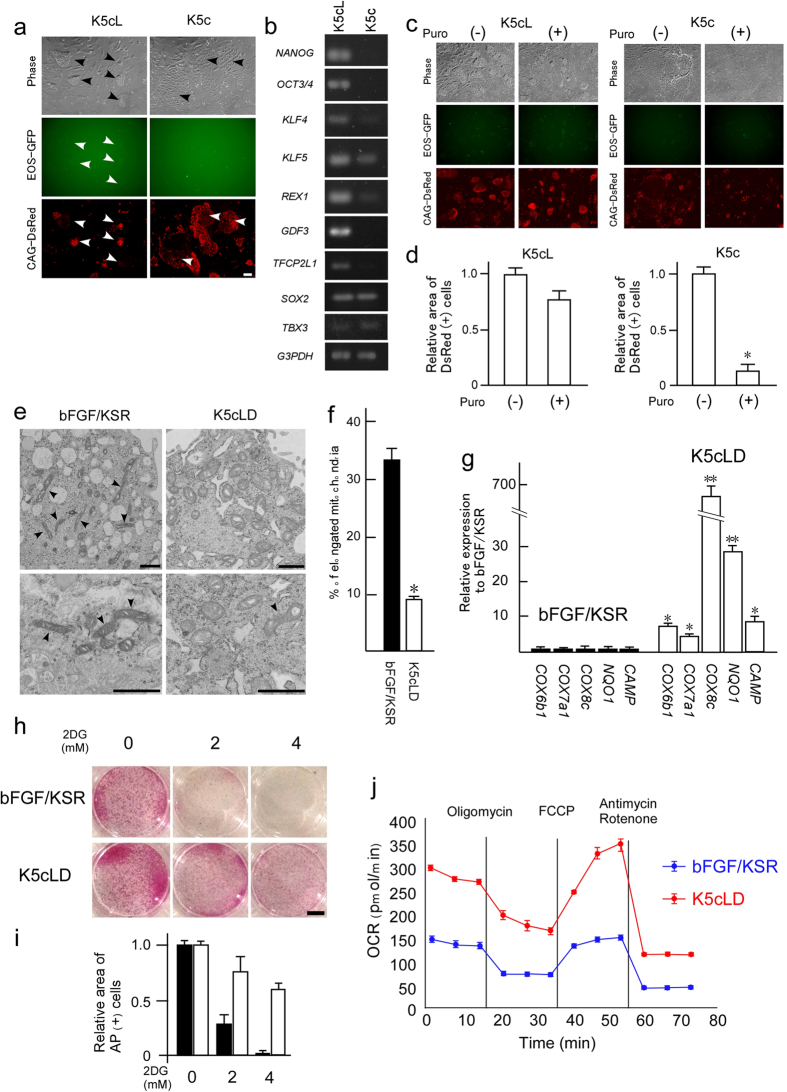
Reactivity of LIF and mitochondrial alterations according to naïve-like conversion of Cm ESCs.(a) Phase contrast images (Phase), EOS-GFP, and CAG-Su9DsRed signals of naïve-like Cm ESCs cultured in the presence (K5cL medium) and the absence (K5c) of LIF. After withdrawal of LIF, cobble-stone-like colonies appeared, and faint EOS-GFP signals disappeared completely. Scale bar = 100 μm. (b) Semi-quantitative RT–PCR of naïve-like Cm ESCs before and after withdrawal of LIF. The mRNA expression of all examined naïve pluripotency-related genes decreased or disappeared after the withdrawal of LIF. (c and d) Puromycin resistance assay using naïve-like Cm ESCs before and after the withdrawal of LIF. Colony morphology and fluorescence signals are shown as images (c) and as quantitative evaluations (d). In the absence of LIF (–), almost all naïve-like Cm ESCs disappeared with puromycin treatment. (e and f) Electron microscopic images (e) and their quantification (f) of the mitochondria in Cm ESCs before (bFGF/KSR) and after (K5cLD) naïve-like conversion. Before naïve-like conversion, primed-state ESCs contained more elongated mitochondria (arrowheads) than naïve-like converted cells. Scale bar = 1 μm. (g) RT–qPCR of potential regulators involved in mitochondrial respiration, COX6b1, COX7a1, COX8c, NQO1, and cytochrome oxidase (COX)-associated mitochondrial protein (CAMP) before (bFGF/KSR medium, closed bars) and after (K5cLD medium, open bars) naïve-like conversion. All genes examined were upregulated by naïve-like conversion. (h and i) AP positive colony formation (h) and quantification (i) with 2-deoxyglucose (2DG) treatment. Scale bar = 1 cm. Within a week, almost all Cm ESCs in primed culture conditions (bFGF/KSR) disappeared in the presence of 4 mM of 2DG. (j) Graph of OCR changes in naïve-like ESCs and primed ESCs. Error bars indicate the S.D. *P < 0.05; **P < 0.01.